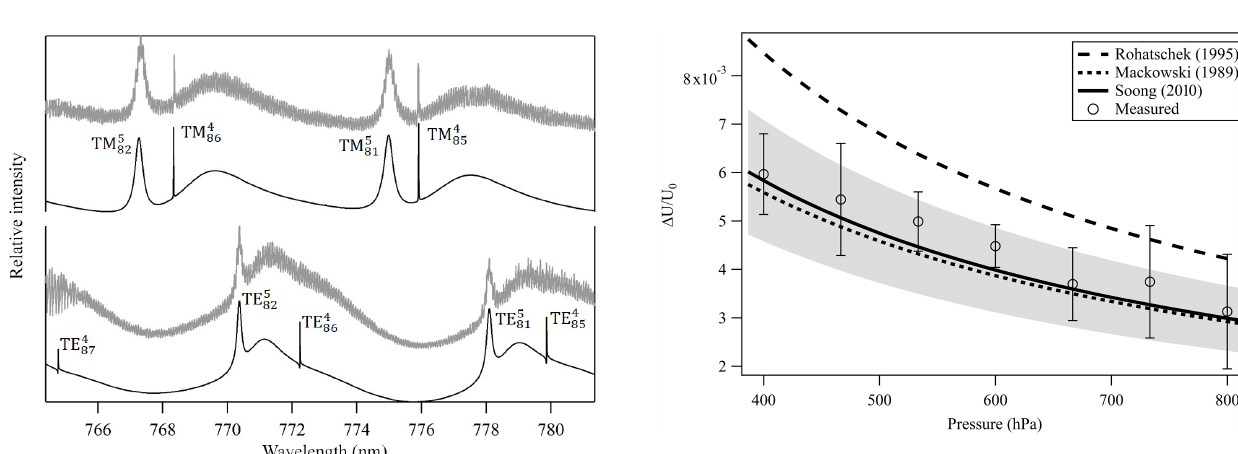
Figure 5. Measured and simulated EDB response ( (cid:49)U/U 0 ) to the illumination of a slightly absorbing particle due to the photophoretic effect. The two analytical solutions Mackowski (1989) (dotted line) and Soong et al. (2010) (solid line) that account for slip-flow condi- tions agree well with our measurements (empty circles). Error bars: standard deviation over five illumination cycles. Gray shaded area: measurement uncertainty propagated through the Soong model cal- culation, dominated by the 15% uncertainty on the radiant flux mea- sured with a power meter and a beam profiler. Table 1. Thermal conductivity (Wm − 1 K − 1 ) of organic com- pounds from Latini et al. (2014) and references